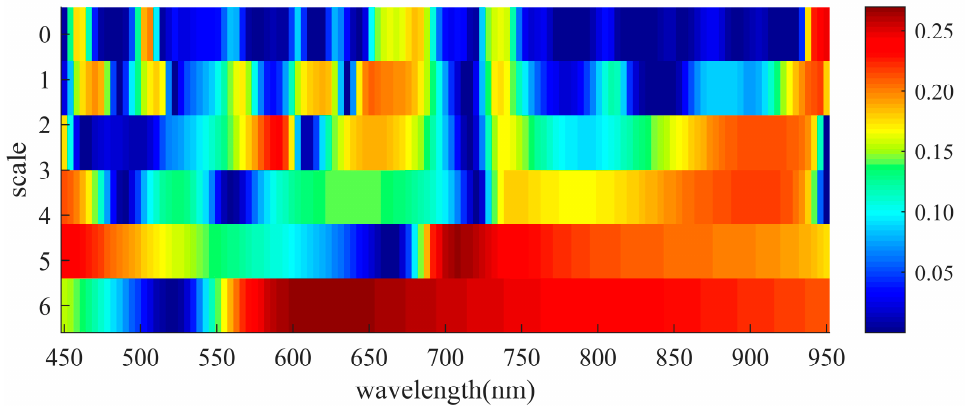
Figure 3. Disease-sensitive wavelet regions extracted from UAV hyperspectral imagery.